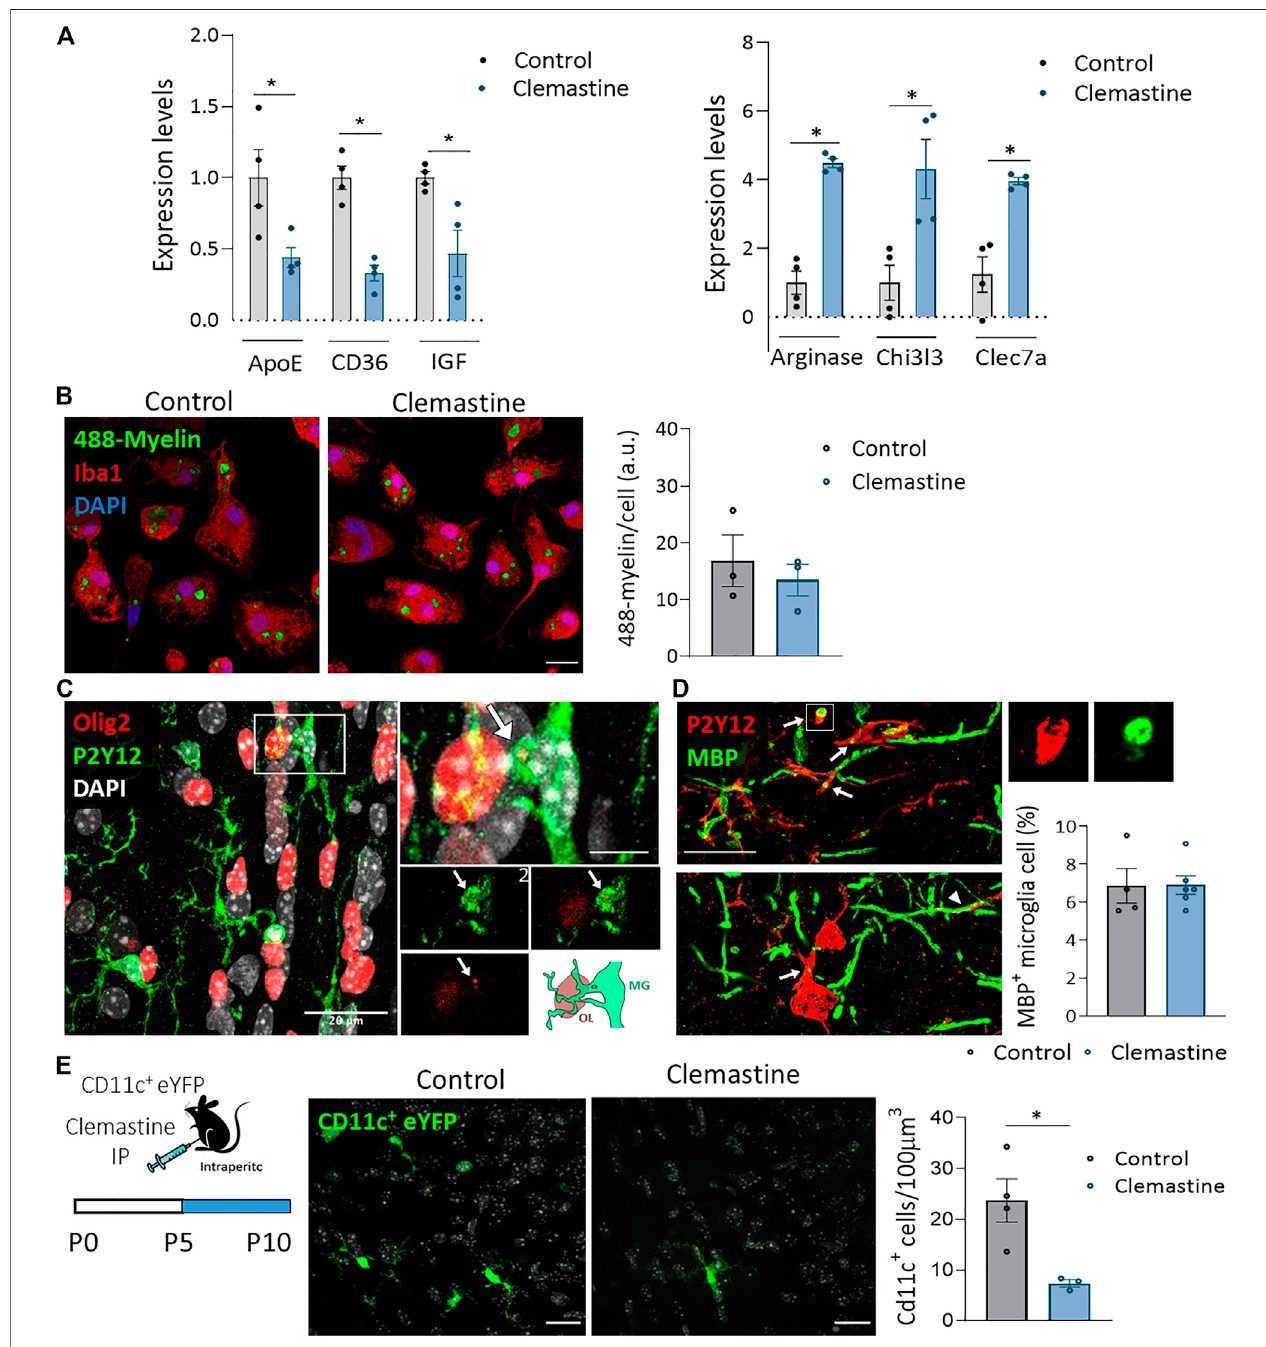
FIGURE6|(A) GeneexpressionofArginase,Chi3l3andclec7a,anti-in fl ammatorymarkers,ofApoE,adiseaseassociatedmarker,ofCD36,aphagocyticmarkerandof IGF,agrowthfactorinvolvedinmyelinogenesis.Theexpressionlevelsofgenesarepresentedusingfold-changevaluestransformedtoLog2formatcomparedtocontrol( n =4 mice per group). (B) Representative images and histogram showing Alexa-488-labeled myelin endocytosis (1 h, 37 ° C) by primary microglia in control and clemastine-treated cultures( n =3independentexperimentsperformedinduplicate).Scalebar=10 μ m. (C,D) RepresentativeconfocalimagesofP21 corpuscallosum showingengulfment of Olig2 + oligodendrocytes (red) by P2Y12 + microglia (green) (C) and of MBP + myelin (green) by Iba1 + microglia (red) (D) . Arrows indicate Olig2 + or MBP + fragments inside microgliacell.Arrowhead,amicrogliaprocessphysicallyinteractingwithamyelinsheath (D) .Scalebar=20 μ m (C) ,5 μ m[insetin (C) ]and15 μ m (D) . Right ,histogramshows thepercentageofmicrogliacellswithinternalizedMBPincontrolandclemastine-treatedP21mice n =4-6mice per group. (E) AnalysisofthenumberofCD11c + cellsincontrol and clemastine treated CD11-eYFP mice. Representative z confocal images and histogram showing that clemastine reduced the number of CD11c + cells ( n = 3-4 mice per group). Scale bar = 20 μ m* p < 0.05, ** p < 0.01.